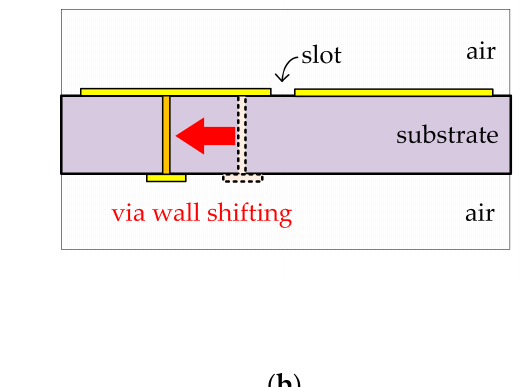
Figure 8. Via wall shifting in the CC ′ - DD ′ section: ( a ) bottom view; ( b ) side view.